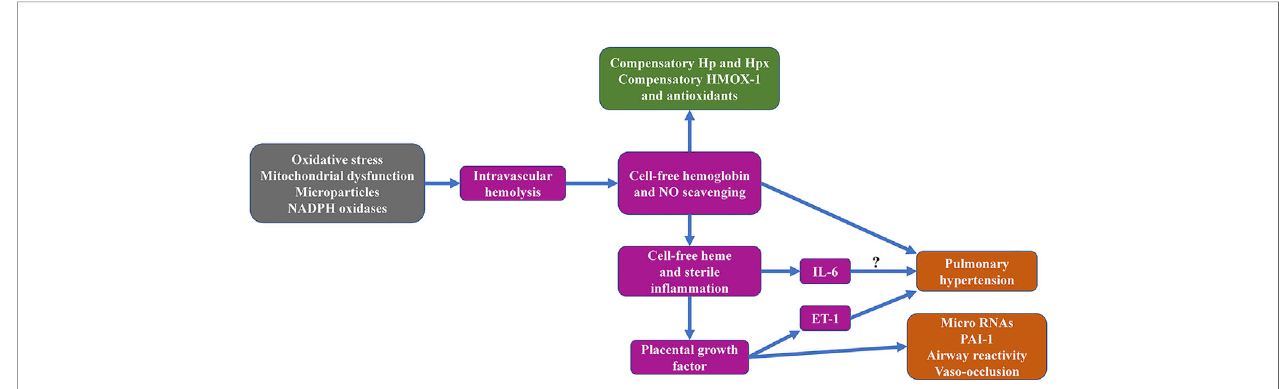
FIGURE 1 | Graphical overview of sickle cell hemolysis-associated topics addressed in the current review